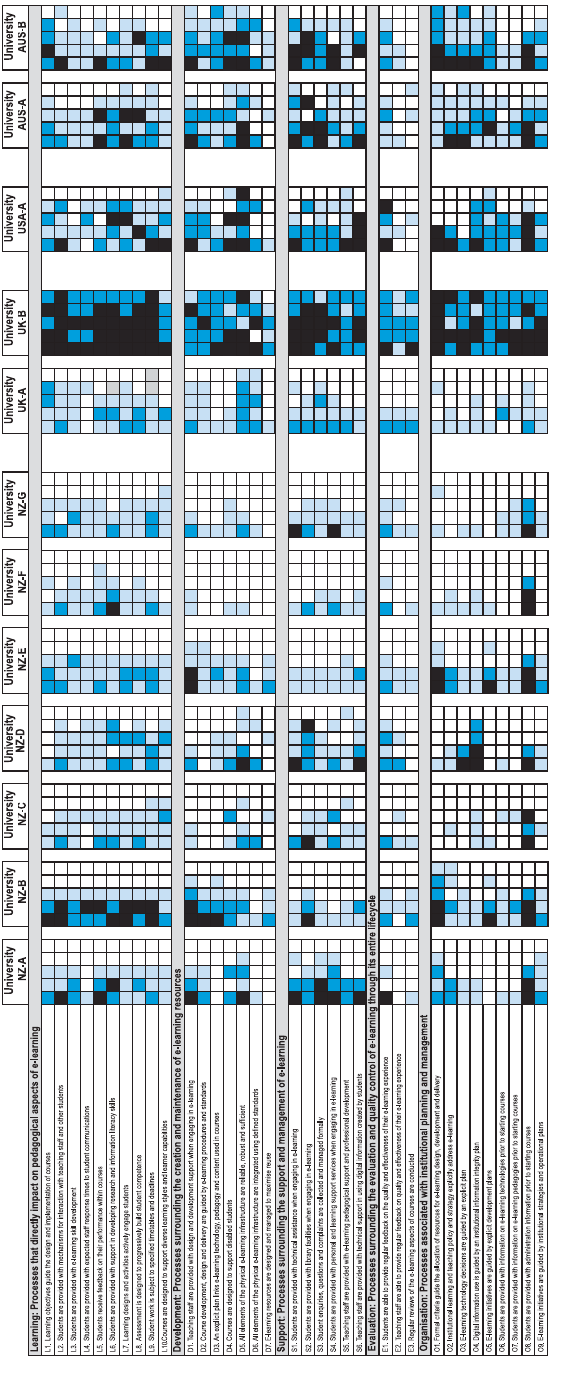
Figure 3. eMM capabilities of international universities (Marshall